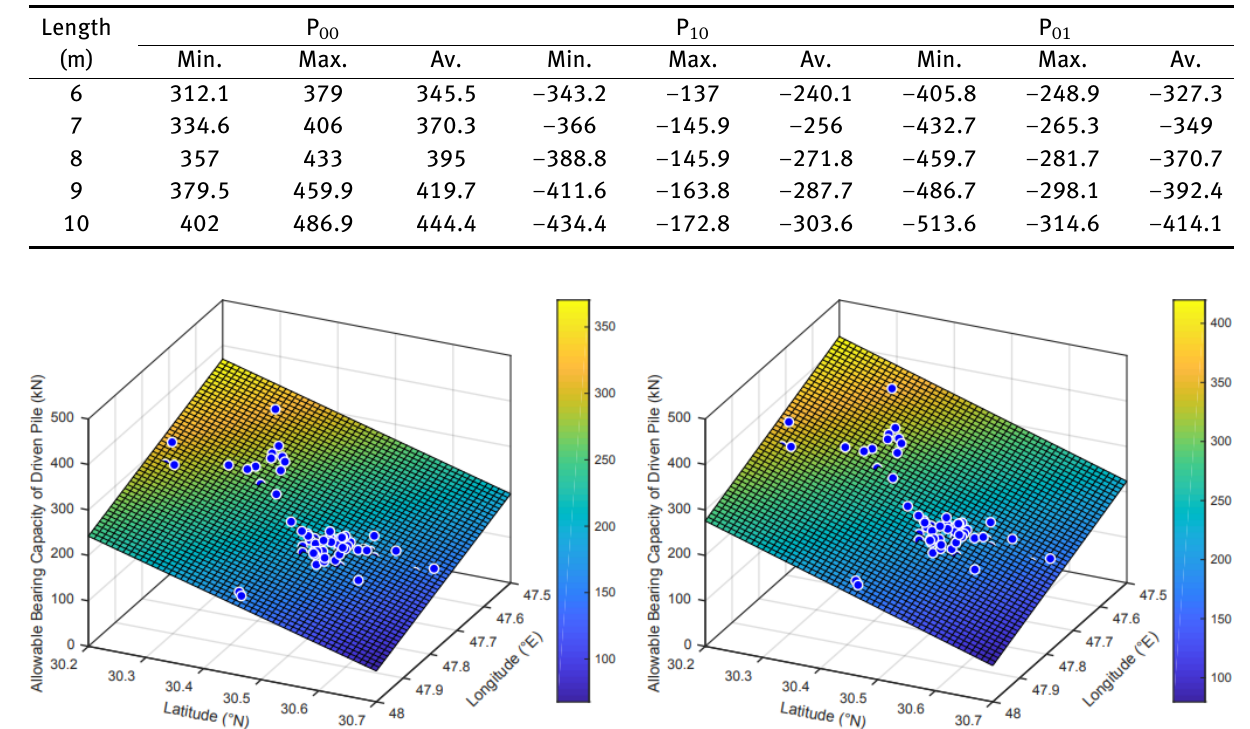
Figure 7: Surface defining the variation of the allowable bearing capacity of the driven pile having 7 m length